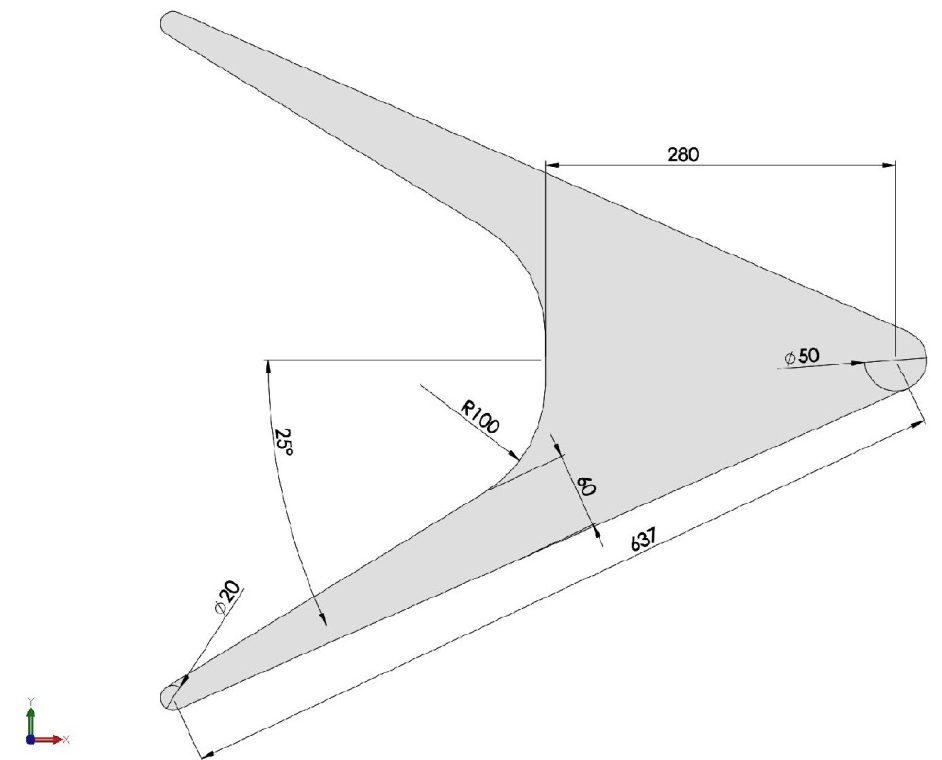
Figure 3. The Delta VLFS configuration modeled for the mooring analysis (top view). Table 1. The Delta VLFS—additional dimensions. Length over all (parallel to the x axis in Figure 3)